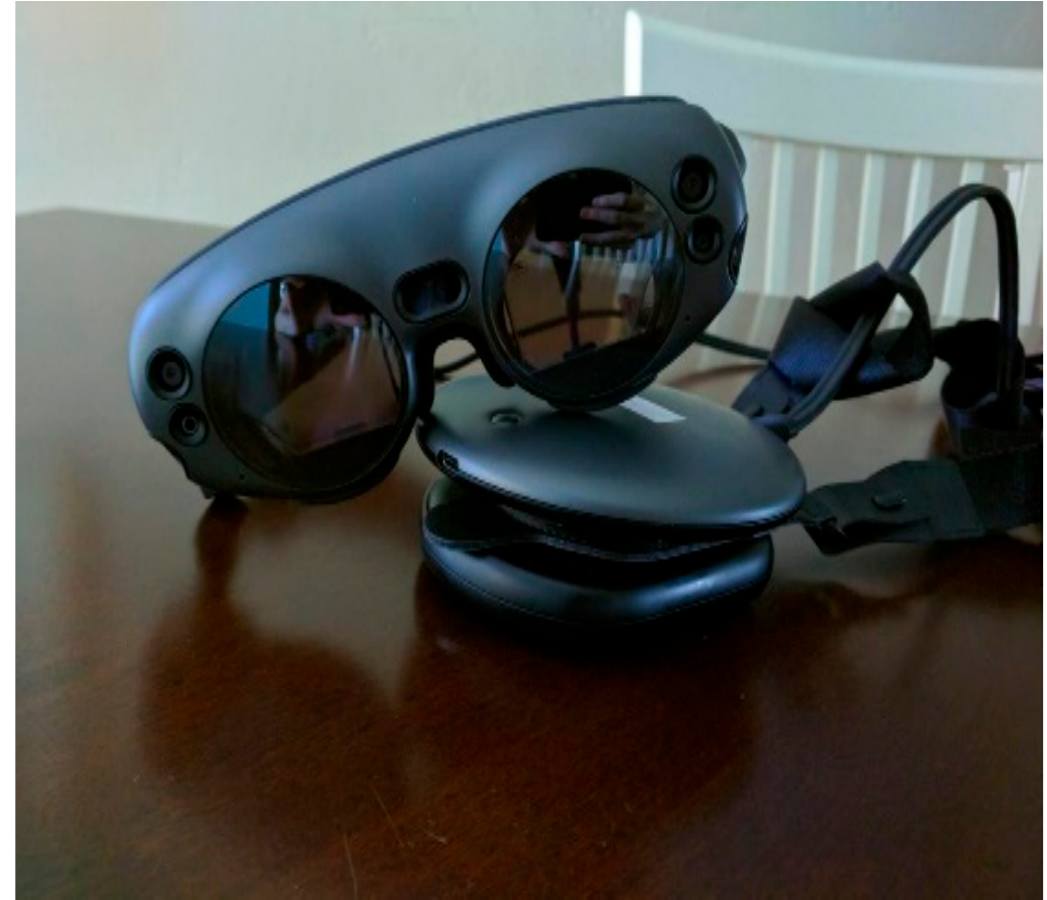
Figure 1. Magic Leap One TM kits include a headset, a portable computer/battery pack, and a controller. Source: University of Miami IT Department.